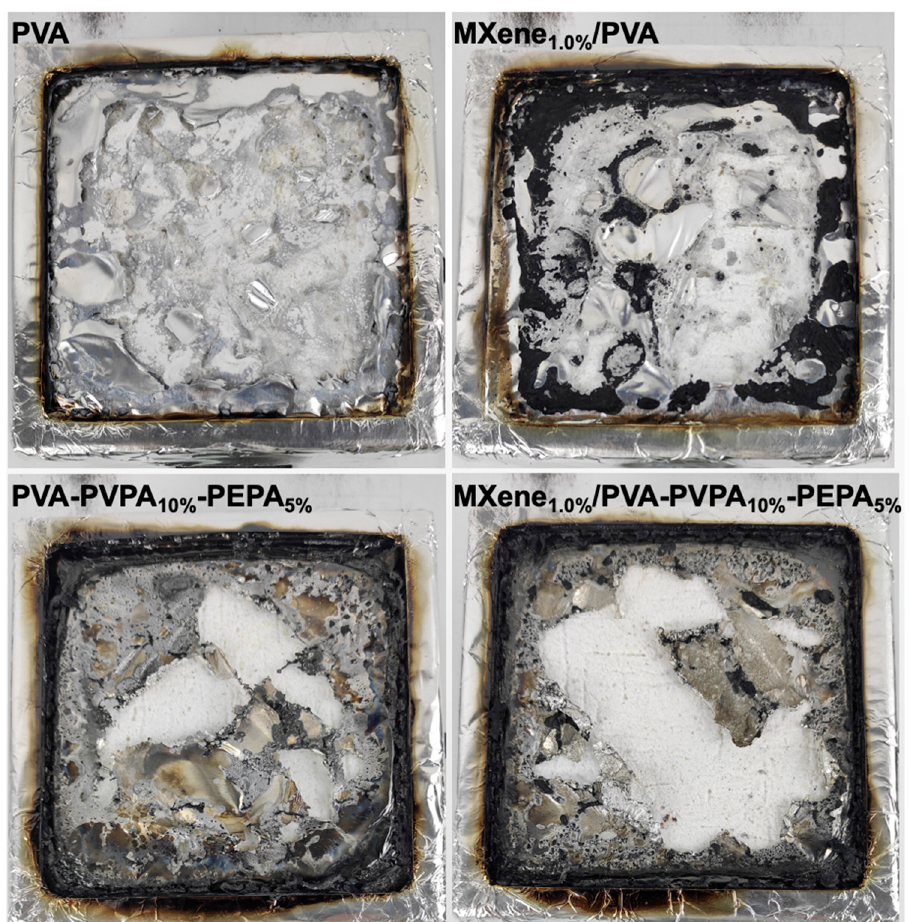
Figure 6. Char residue of PVA and MXene/PVA nanocomposites after cone calorimeter test. The char residue microstructure of PVA and MXene/PVA nanocomposites after cone calorimeter test was observed by SEM, as illustrated in Figure 7. It was observed that there were a lot of micropores on the outer surface of MXene 1 . 0% /PVA and MXene 1 . 0% /PVA-